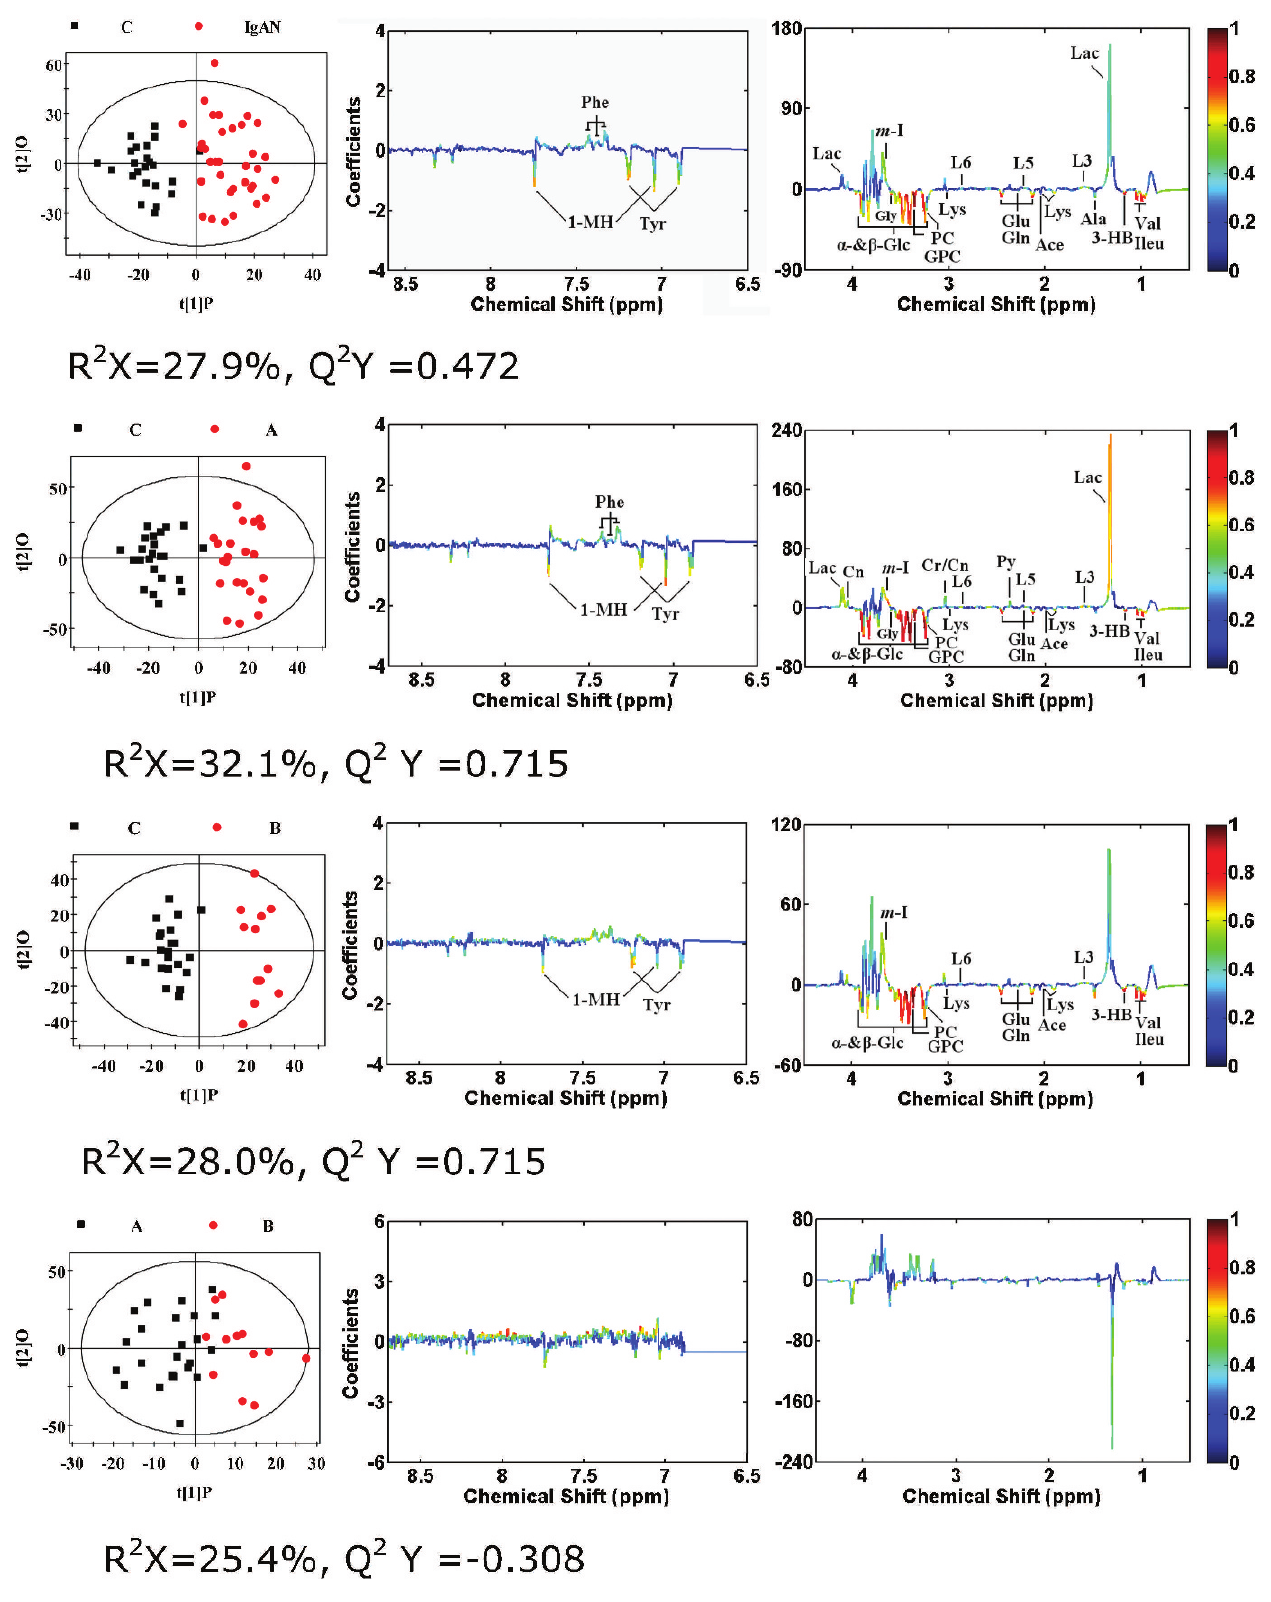
Figure 4 - OPLS-DA score plots (left panel) derived from 1 H NMR spectra of serum and corresponding coefficient loading plots (middle and right panels) obtained from different groups. Keys for the assignments are shown in Figure